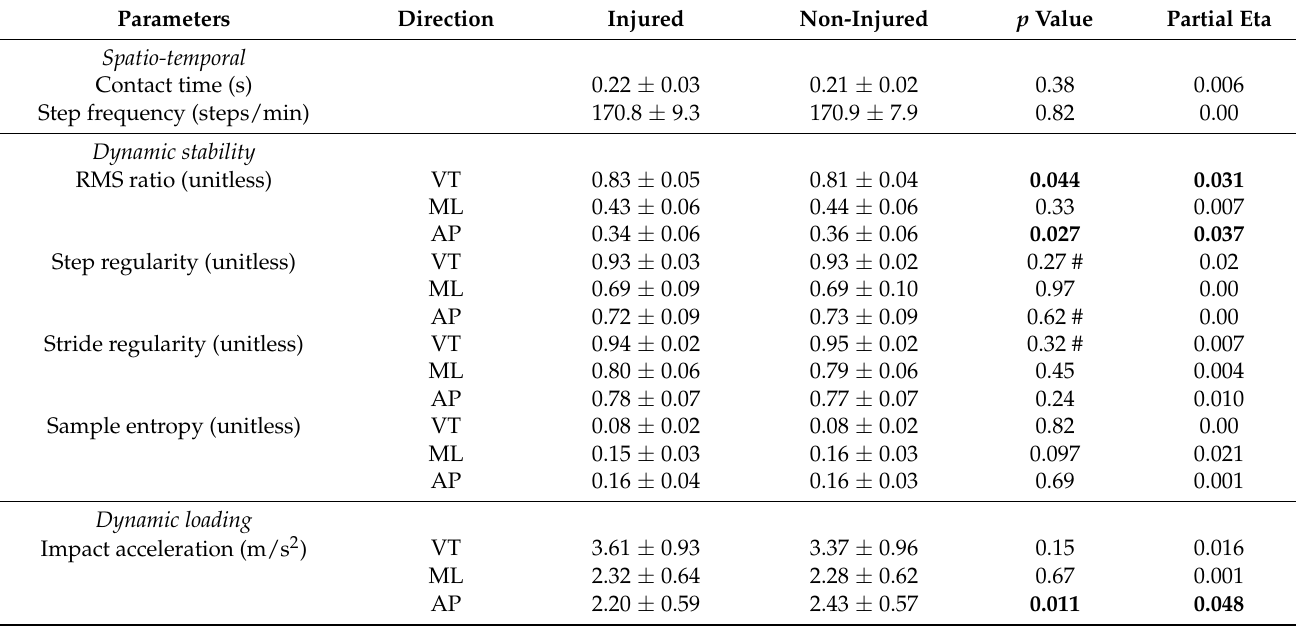
Table 3. Trunk accelerometry-based measures for participants that sustained an injury compared to the uninjured group at baseline i.e., during the 10–20% of the run. Values are means ± SD. Parameters Direction Injured Non-Injured p Value Partial Eta